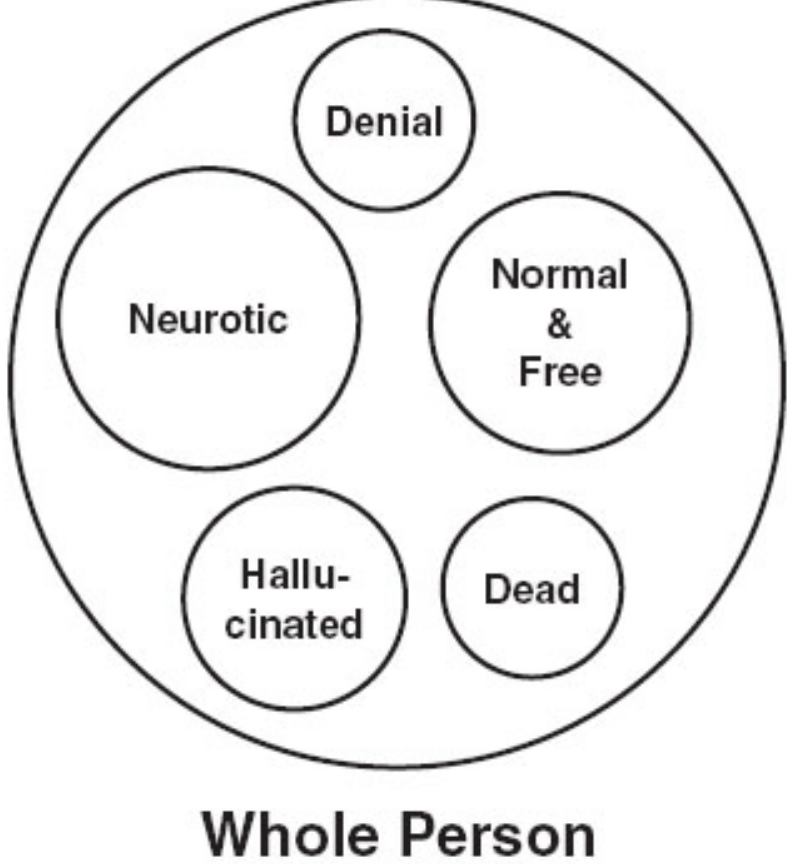
FIGURE 3. In practice, the patient almost always contains multiple personalities and the parts live their own lives, to a large extent. This means that different parts of the person coexist in different states. This is the analysis from holistic existential therapy of a 26- year-old female breast-cancer patient, made during the session to educate her to confront and assume responsibilities for all her “inner parts”. One part of her is romanticizing and not meeting the real world (called hallucinated), another part of her is completely dead, while the largest part of her is